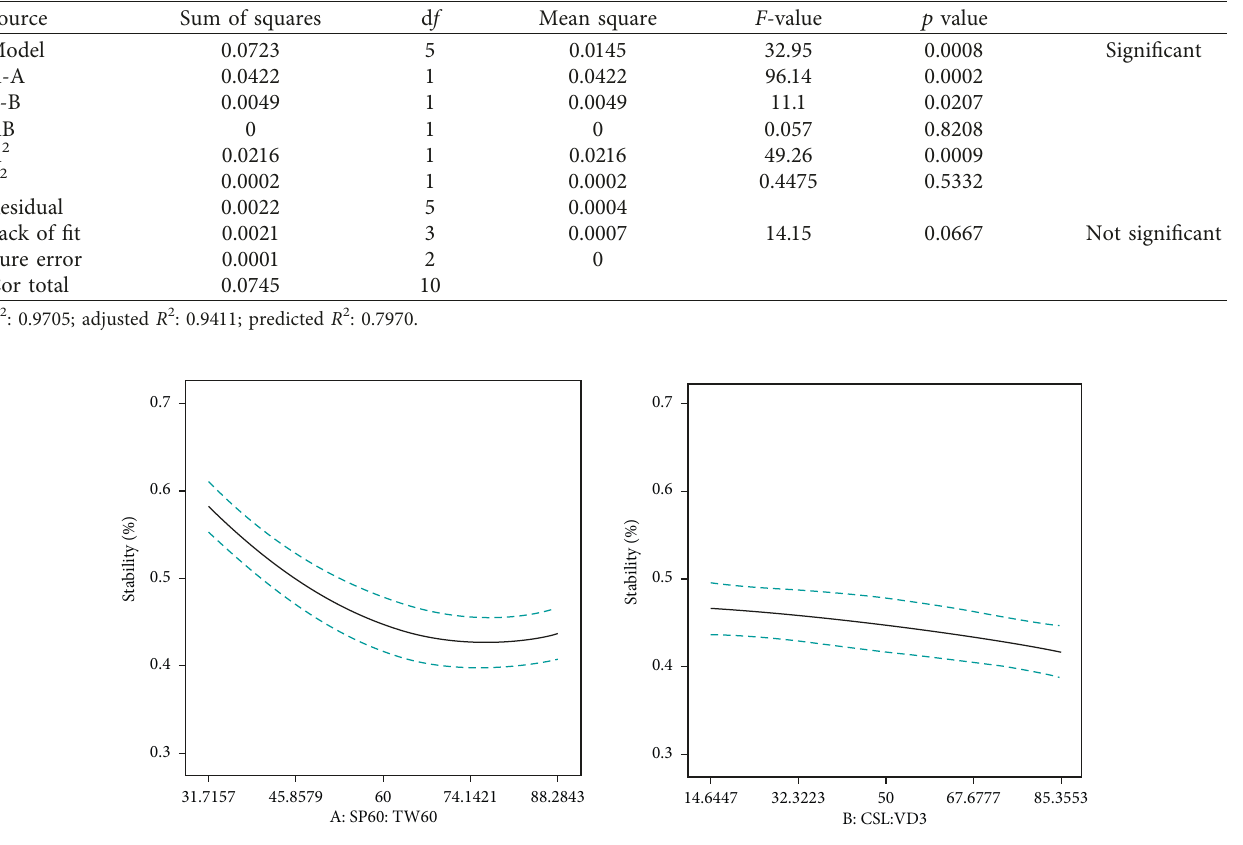
Figure 4: Effects of Span 60: Tween 60 and cholesterol: vitamin D3 ratio on stability of